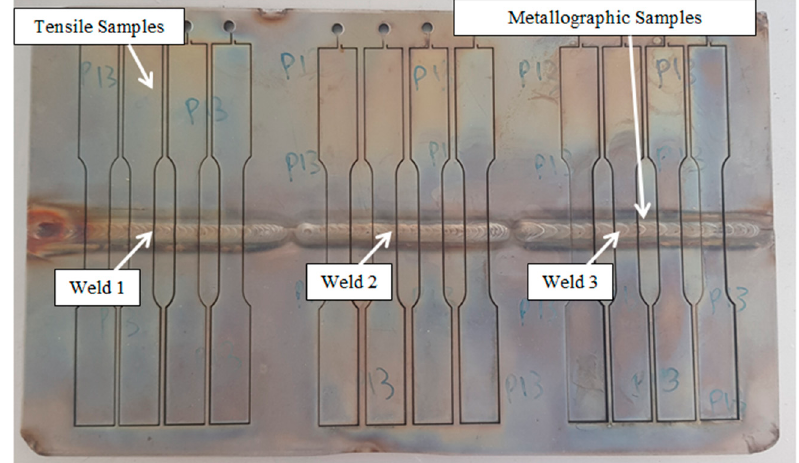
Figure 12. Location of the tensile samples relative to the welded sheets. Four samples were extracted from every weld and tested in tension. Values in Figure 11 are an average of the four tests.